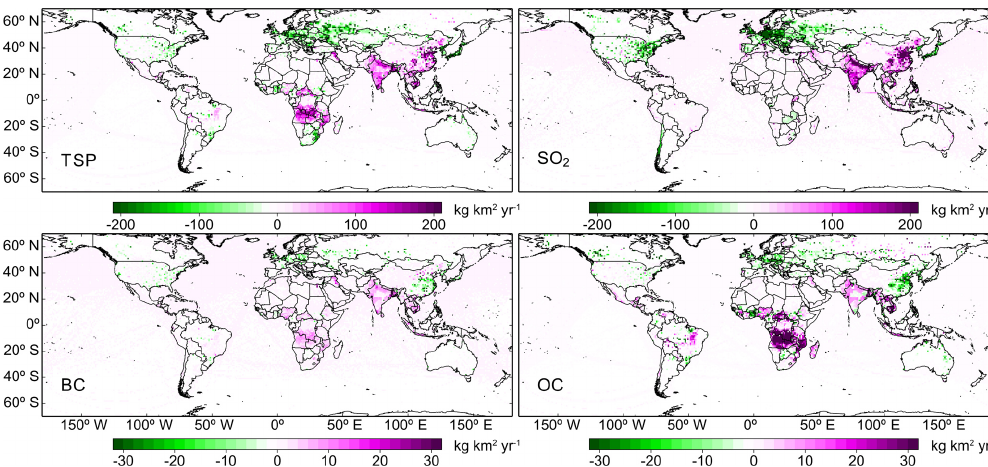
Figure 11. Spatial distributions of linear trends (units: kgkm − 2 yr − 1 ) in total anthropogenic emissions of total suspended particles (TSP), SO 2 , black carbon (BC) and organic carbon (OC) during 1980–2014 derived from the Peking University emissions inventory (http://inventory. pku.edu.cn/, last access: 31 March 2019) (Huang et al., 2014). Only linear trend values with statistical significance at the 95% confidence level are